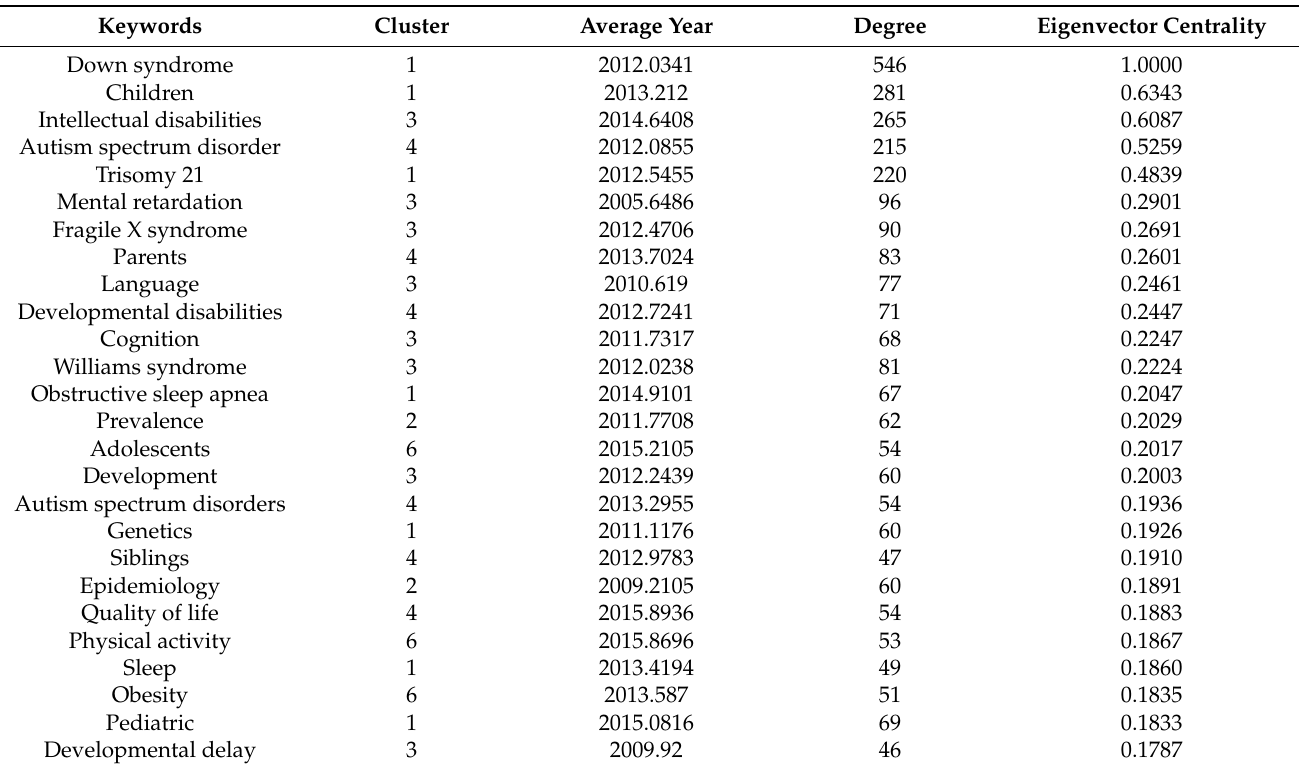
Table 2. The most influential keywords in the co-occurrence network.